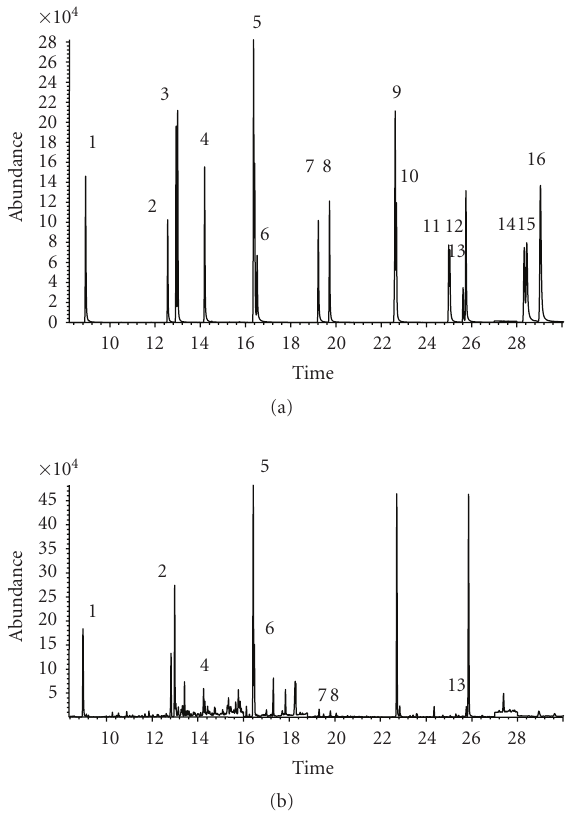
Figure 1: (a) and (b) Chromatogram of polycyclic aromatic hydro- carbons (PAHs) obtained using the GC-MS method. Numbers on the chromatogram refer to the individual PAHs as indicated in Table 2. (a) Standard PAHs (500pg/ μ l), (b) Bread